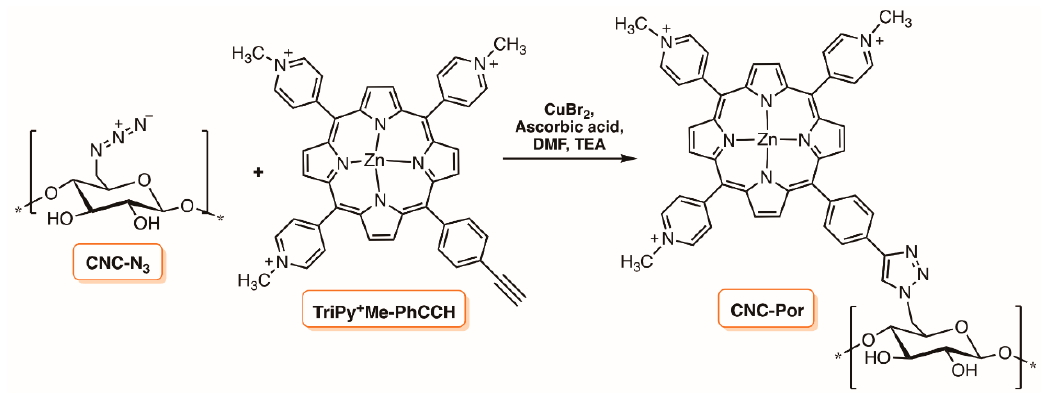
Figure 26. Preparation of a cellulose nanocrystal conjugated to a cationic porphyrin TriPy + Me-PhCCH (adapted from Reference [133,134]).